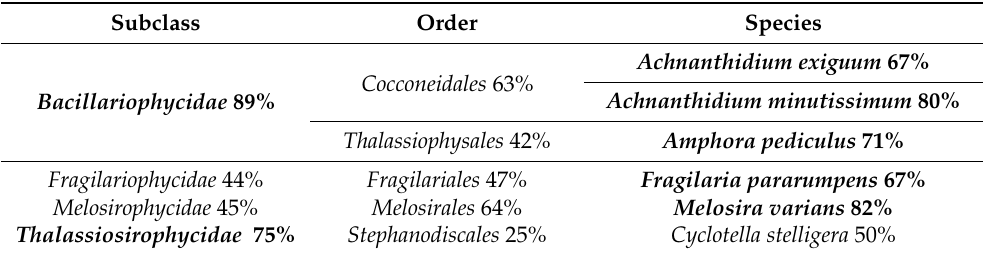
Table 3. Validation sensitivity (%) for the taxa best identified by the Artificial Neuronal Network (ANN) using Raman variables as continuous input variables and the species as categorical target. Diatom species, orders, and subclasses with a sensitivity >65% are indicated in